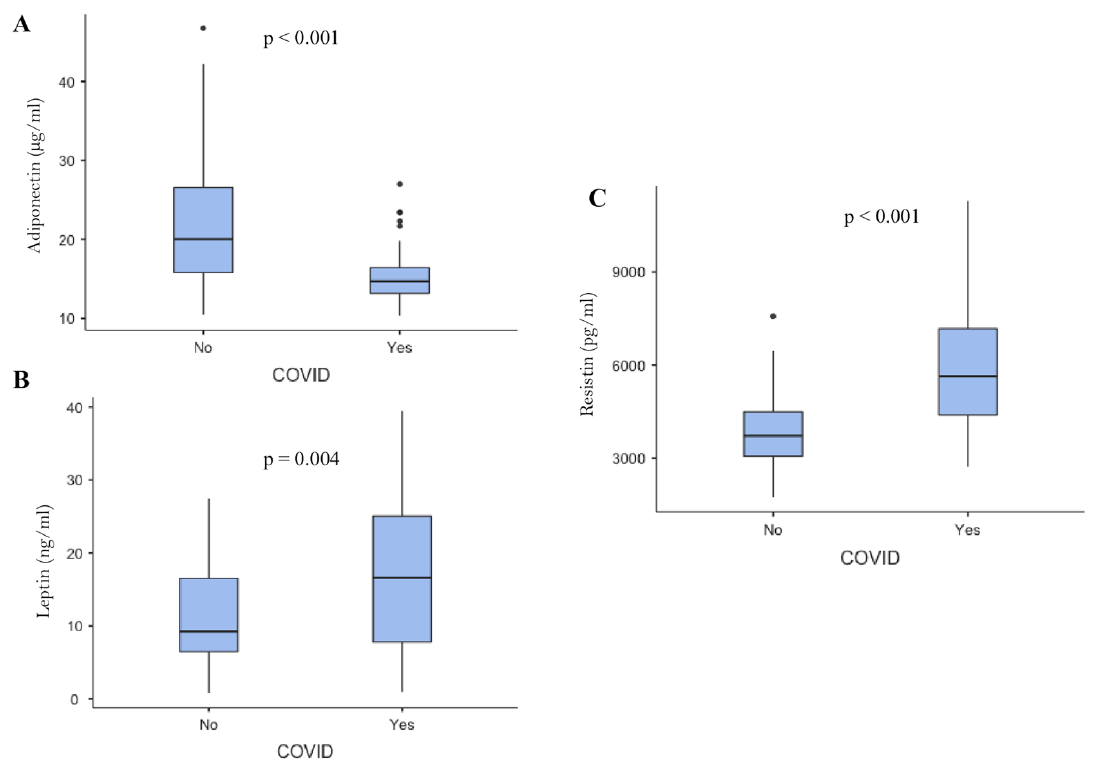
Figure 1. Serum total adiponectin, leptin, and resistin are differently expressed in severe COVID-19 patients compared to healthy controls. ( A ) Adiponectin levels were statistically reduced in patients diagnosed with severe COVID-19 compared to healthy controls (15.11 ± 3.4 vs. 22.92 ± 9.6 μg/mL; p < 0.001). ( B ) Leptin levels were significantly higher in COVID-19 patients than in controls (16.94 ± 10 vs. 12.18 ± 7.2 ng/mL; p = 0.007). ( C ) Resistin levels were significantly increased in patients diagnosed with COVID-19 compared to healthy controls (5859.79 ± 1953 vs. 4165.57 ± 1483 pg/mL; p < 0.0001). * p < 0.05.